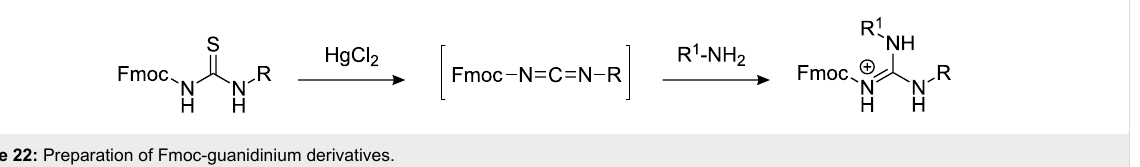
Figure 21: Structure of RNG and DNG .